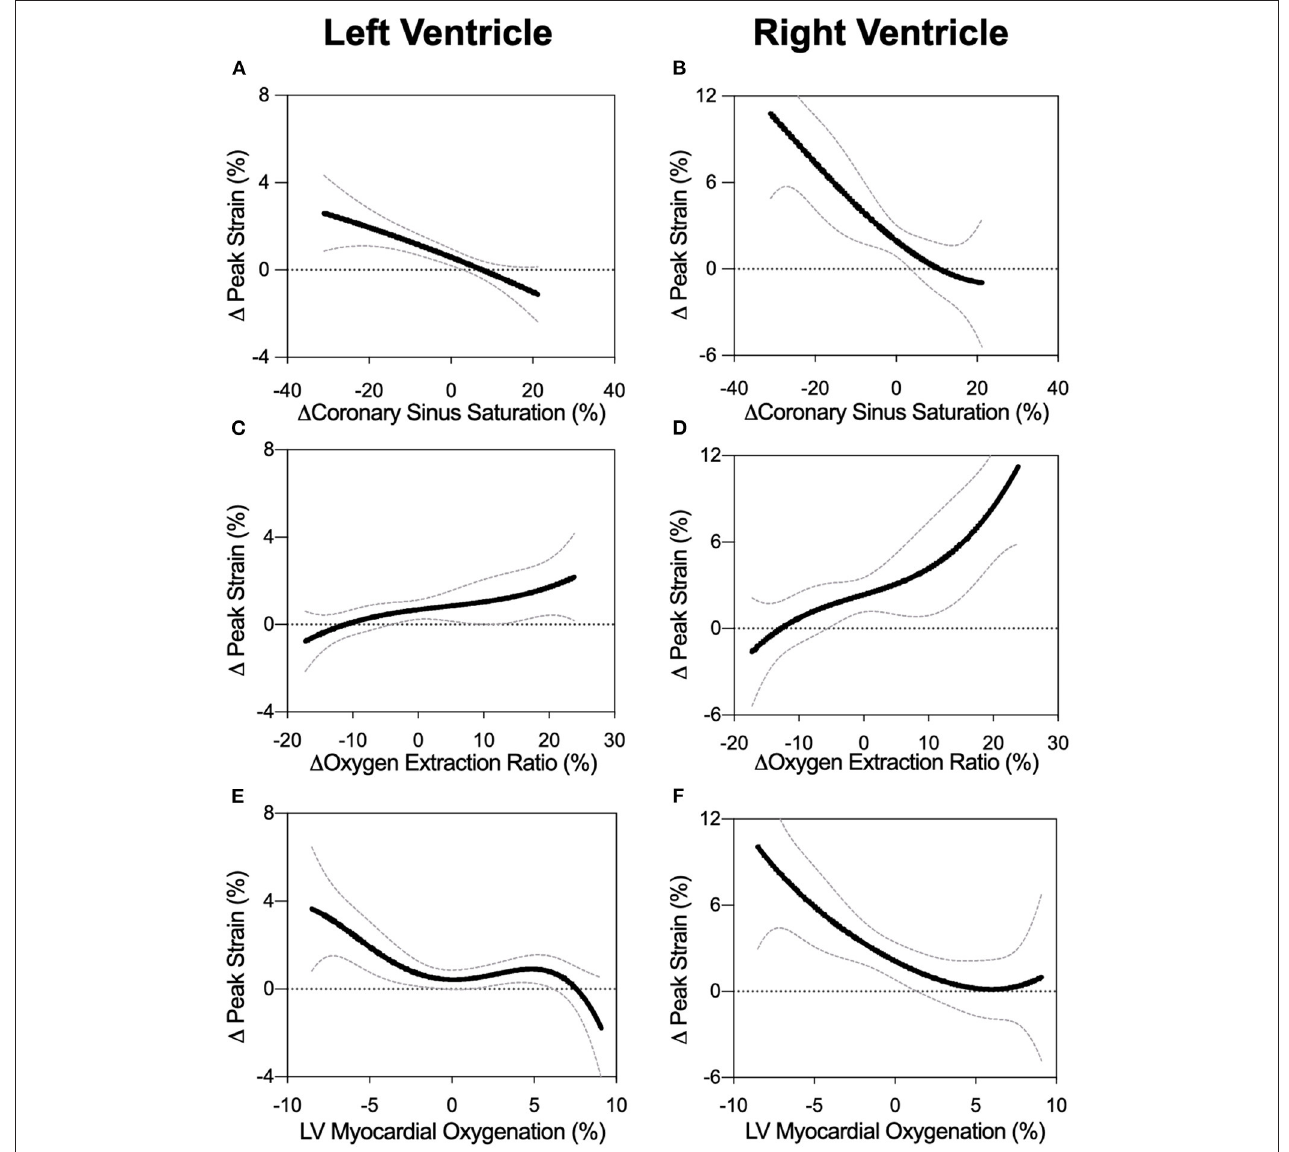
FIGURE 3 | Biventricular GCS in relation to measures of oxygen. Non-linear fits are shown for left and right ventricular peak strain in comparison to changes in coronary sinus oxygen saturation (ScsO 2 , panels A and B ), oxygen extraction ratio (O 2 er, panels C and D ), and the myocardial oxygenation response of the left ventricular myocardium (OS-CMR, panels E and F